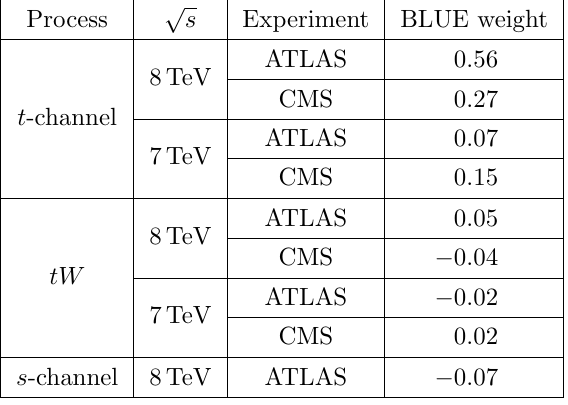
2 f LV V tb j j